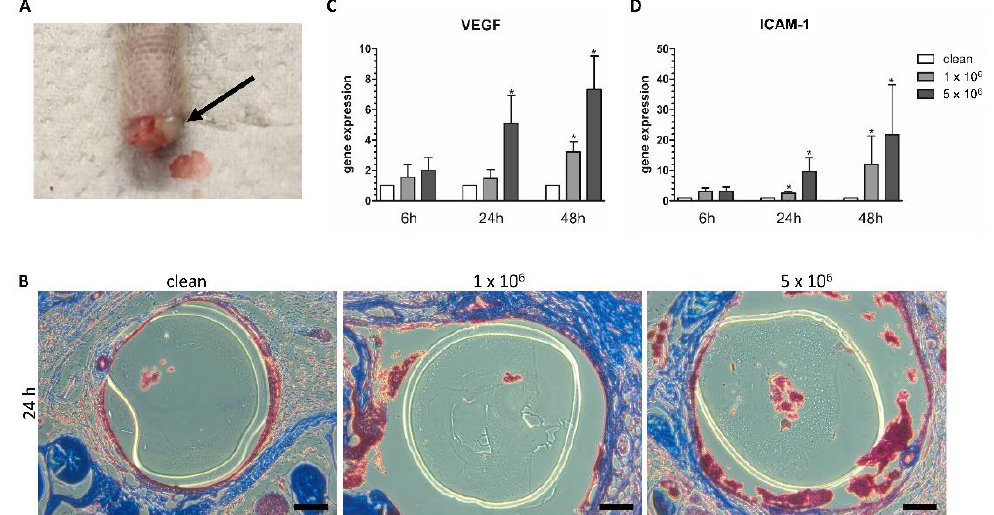
Figure 3. Local endothelium damage originating from the infected implants. ( A ) Purulent secretions at the implantation site after 48 h with 5 × 10 6 CFU (colony forming units) infected implant. ( B ) Histological staining with Masson Trichrome after 24 h, bars 50 µm. Gene expression of ( C ) vascular endothelial growth factor A (VEGF) and ( D ) Intercellular Adhesion Molecule 1 (ICAM) after 6 h, 24 h and 48 h, *: p <